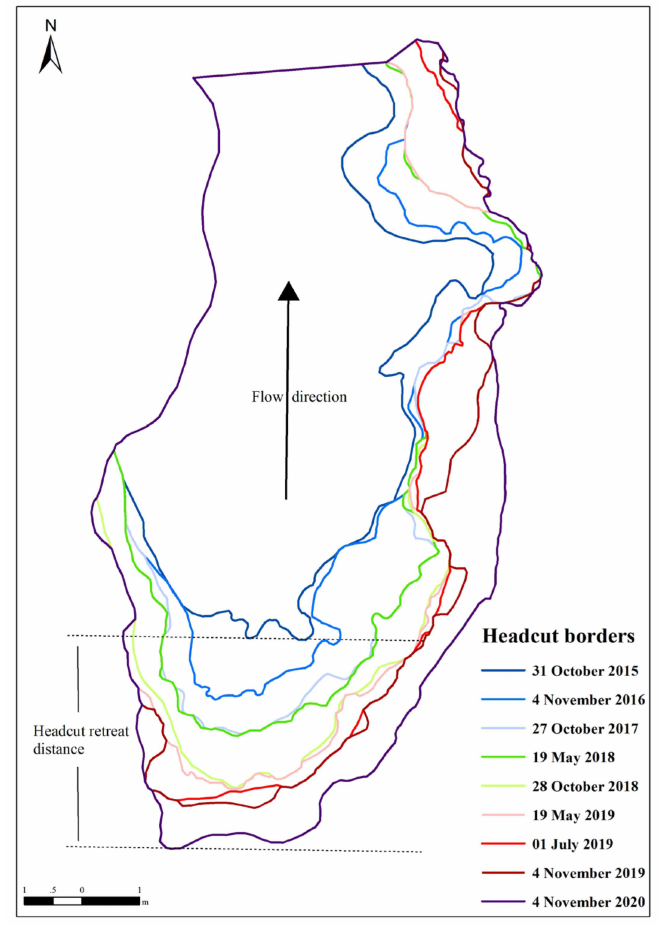
Figure 14. Headcut retreat between 2015 and 2020. However, compared with the existing research on the northern black soil region of northeast China [16,36–38], the southern region exhibited a lower GHR rate. Compared with the northern region, the southern black soil region has higher rainfall erosivity but a shorter slope length; the freeze–thaw duration is shorter, and the temperature differ- ence during the thawing period is smaller [65]. With the increase in slope length, the development space of the gully increases, and the runoff acceleration increases. Moreover, the longer the freeze–thaw duration and the larger the temperature difference during the thawing period, the more the aggravation of damage to the soil structure and the more the reduction in soil corrosion resistance. The differences in terrain, freezing–thaw duration, and temperature resulted in the rainfall erosivity having stronger and weaker effects on gully development in the northern and southern regions, respectively